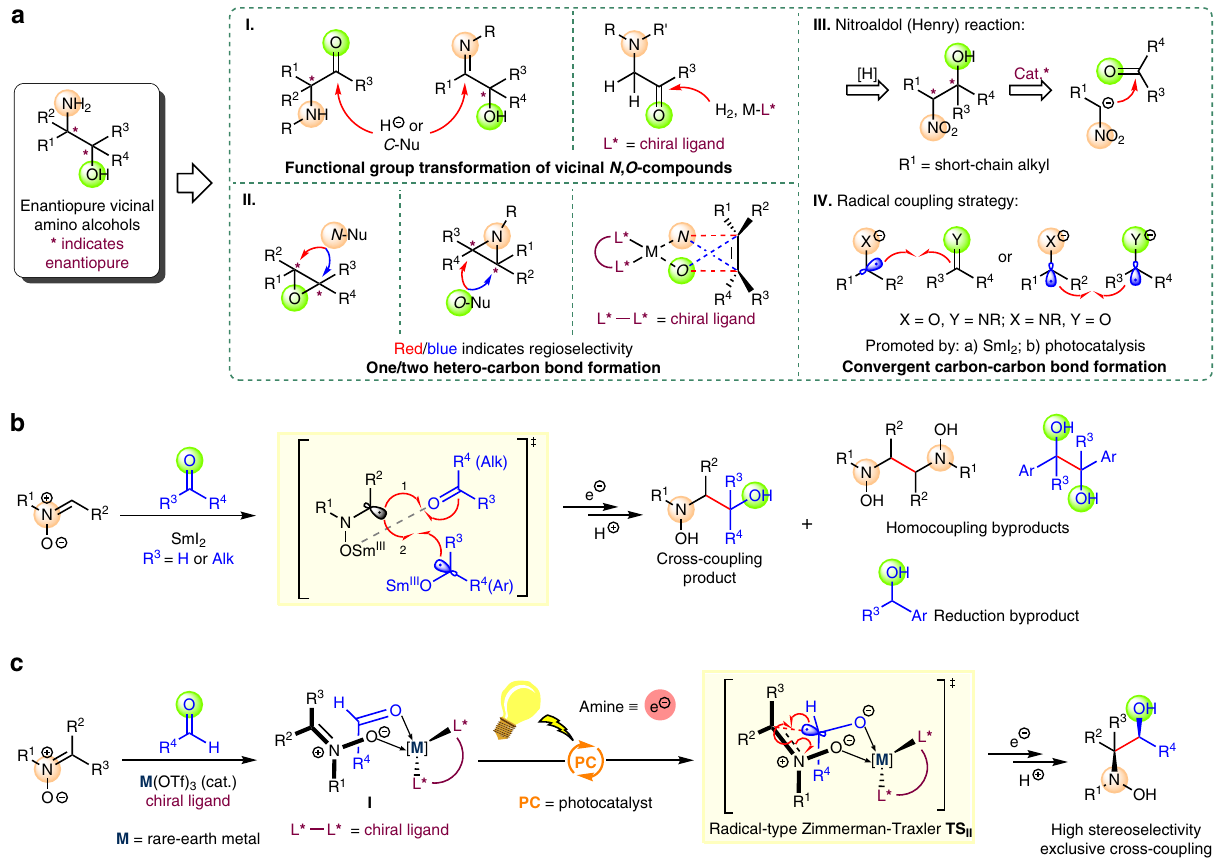
Fig. 1 Retrosynthetic analysis and synthetic protocols of enantiopure vicinal amino alcohols. a The general protocols for synthesis of enantiopure vicinal amino alcohols and their derivatives. b Previous studies by Py and our group on SmI 2 -mediated cross-coupling of nitrones with aldehydes/ketones may lead to homocoupling and reduction byproducts and are not ideally suitable for developing catalytic enantioselective variant. c Enantioselective reductive cross-coupling reaction of nitrones with aromatic aldehydes via the synergistic catalysis of chiral ligand-coordinated Lewis acid and photocatalyst was described. Through the radical-type Zimmerman – Traxler TS II , vicinal hydroxyamino alcohols could be obtained exclusively with high stereoselectivity. This mild reaction is operationally simple with a wide array of nitrones and aromatic